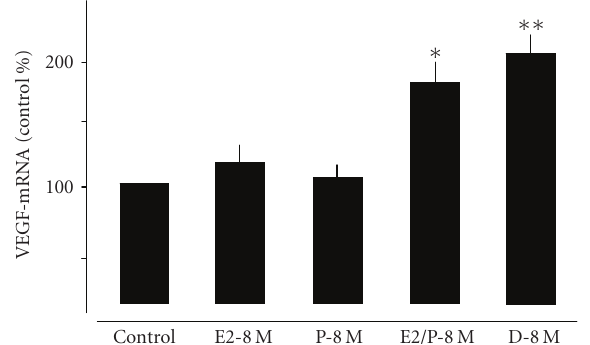
Figure 6: Quantitative analysis of VEGF gene expression in alveolar cells type II treated for 48 hours with E2-8M and P- 8M alone or in combination. Values were normalized against a housekeeping gene (HPRT) and expressed as % of controls. Note that only the combined application of both hormones significantly increased VEGF expression in central lung fibroblasts. Also note that the application on dexamethasone had similar e ff ects on VEGF expression. ∗ P < . 01 control versus E2/P-8M, ∗∗ P < . 01 control versus D-8M.